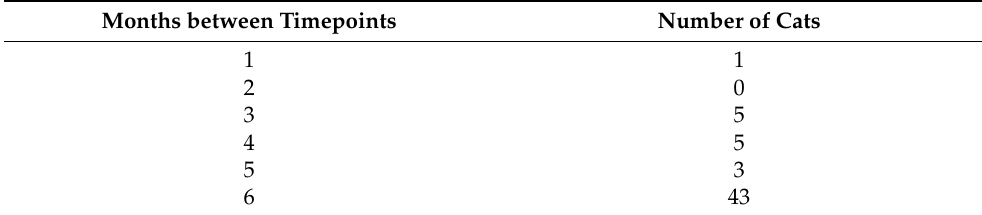
Table 2. Number of months between collection times of paired